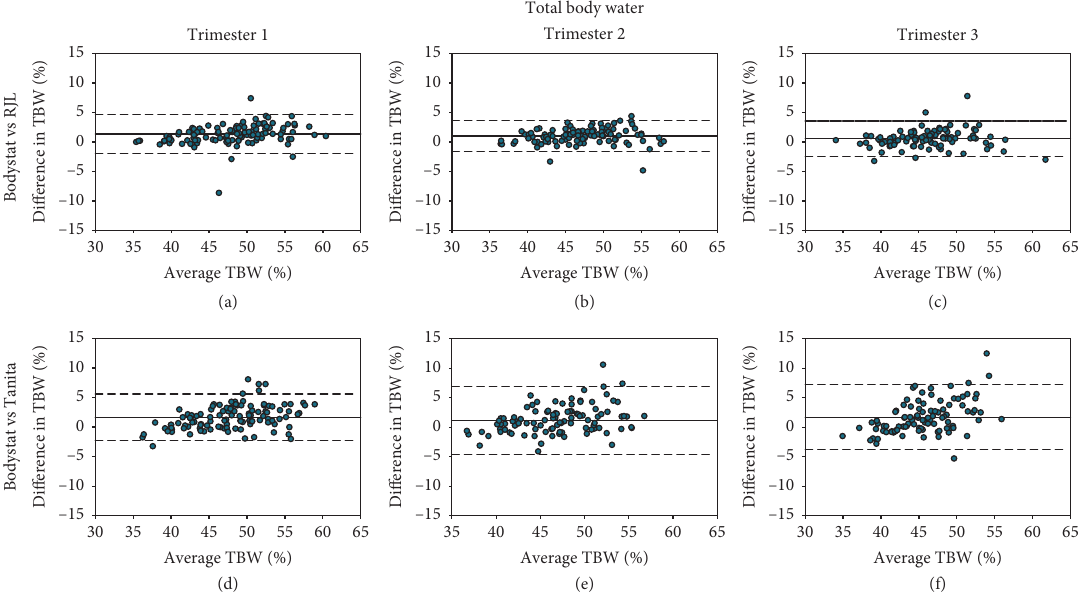
Figure 2: Bland–Altman plots of the differences of TBW% against average TBW% between two methods: (a–c) Bodystat vs. RJL and (d–f) Bodystat vs. Tanita. Differences in TBW% are calculated as Bodystat minus comparison method (RJL or Tanita). TBW: total body water.